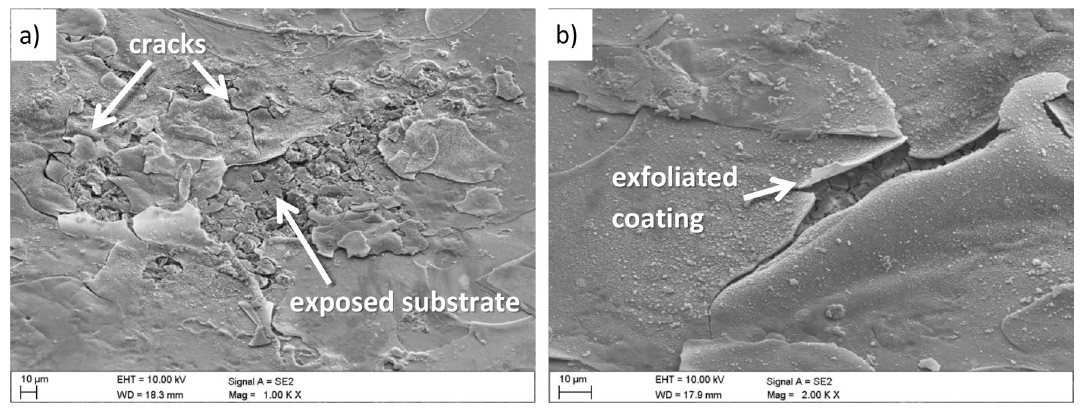
Figure 11. Surface morphology of Al 2 O 3 + TiO 2 coating on the LAE442 alloy substrate after the corrosion